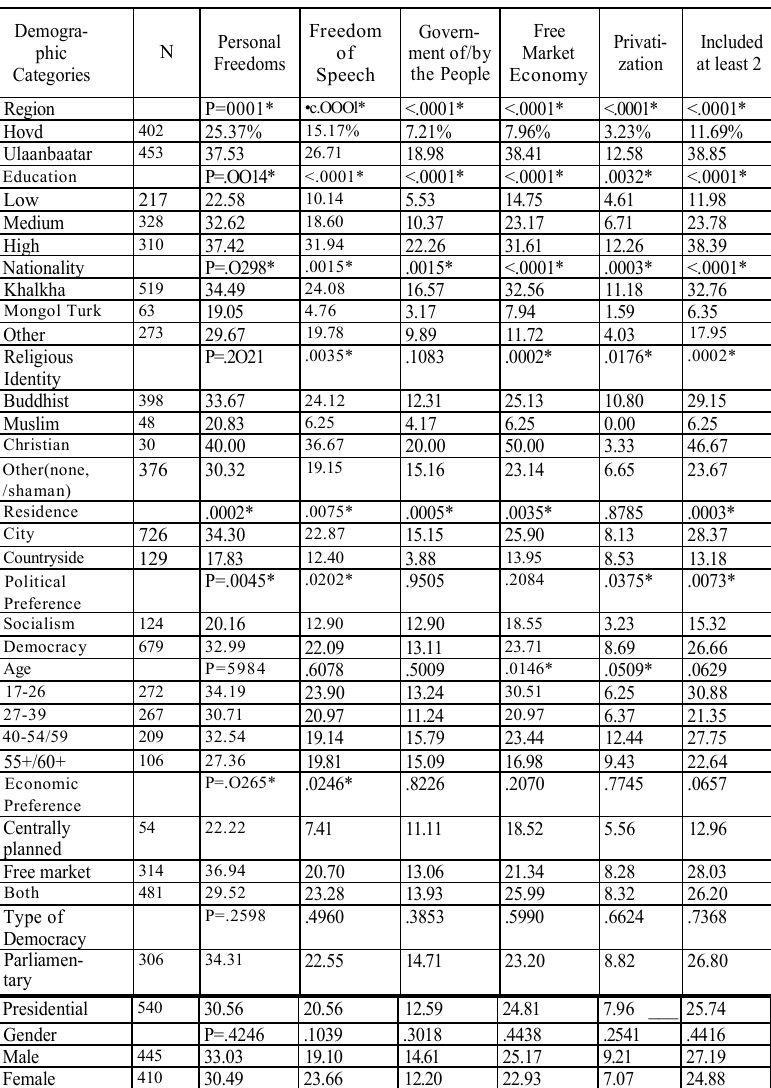
Table 2. Demographic Differences: Respondents’ Ideas on Democracy Demogra-